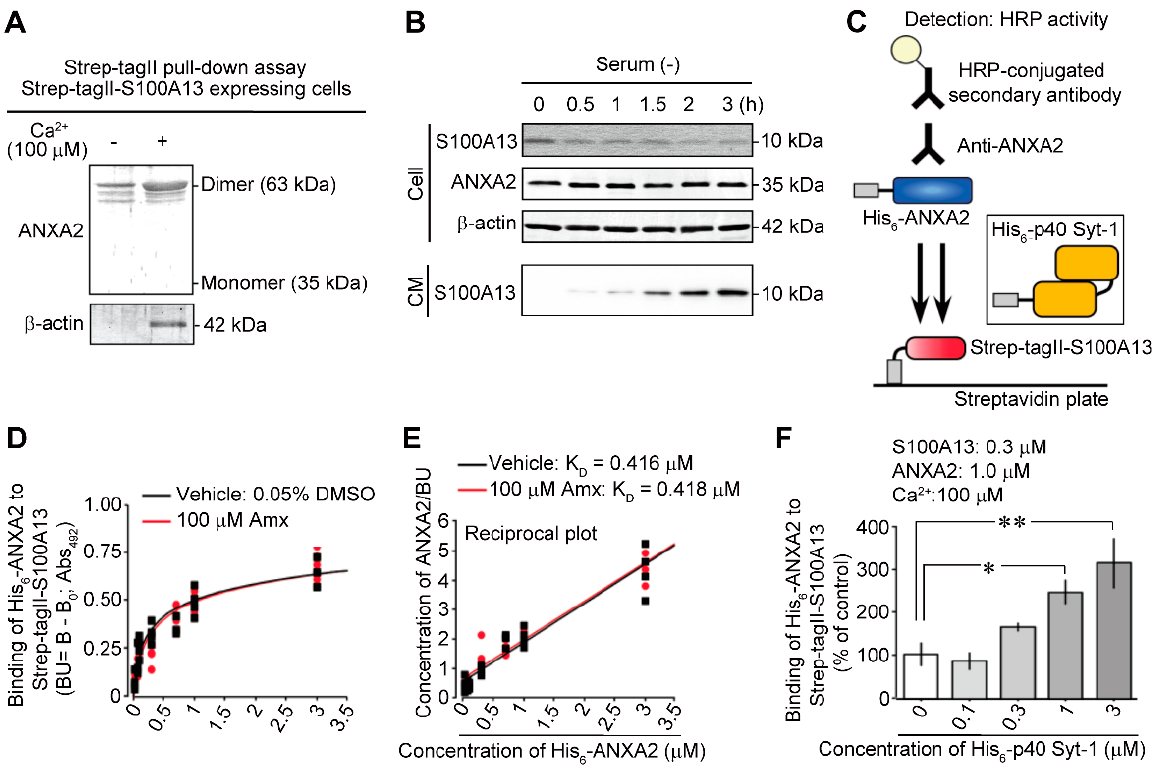
Figure 1. Evidence for Ca 2+ -dependent interaction between annexin A2 (ANXA2) and S100A13 under serum-free conditions. ( A ) Pull-down assay using Strep -tagII-S100A13. Strep -tagII-S100A13 and C6 glioma cell lysates were incubated in the absence (left lane) and presence (right lane) of 100 µ M Ca 2+ . Results represent the immunoblot using anti-ANXA2 IgG (upper lanes) and anti- β -actin antibody (lower lanes). The pull-down assay in Figure 1A showed that ANXA2 dimer interacts with Strep -tagII-S100A13 in C6 glioma cell lysates in a Ca 2+ -enhanced manner. In the previously published study [18], we have shown that p40 Syt-1 also interacts with Strep -tagII-S100A13 in C6 glioma cell lysates in a Ca 2+ -enhanced manner. As both pull-down assays using Strep -tagII-S100A13 have been done with the same C6 glioma cell lysates, it appears that S100A13 forms the same protein complex with both experiments p40 Syt-1 and ANXA2. The experiment was done using same C6 glioma cell lysates as previously reported to show the interaction between Strep- tagII-S100A13 and p40 Syt-1 [18]. ( B ) Serum- free-induced release of S100A13, but not ANXA2 from C6 glioma cells. Results represent the time course of protein levels of S100A13, ANXA2 and β -actin in cells (upper panels) and conditioned medium (CM) (lower panel) by immunoblot analysis. Extracellular S100A13 was recovered from CM using immunoprecipitation. ( C ) Schematic model of interaction between His 6 -ANXA2 and Strep -tagII-S100A13 bound to Streptavidin plate in an ELISA-based protein binding assay. Inset: enhancement of the interaction in the presence of His 6 -p40 synaptotagmin-1 (Syt-1). ( D , E ) No effect of amlexanox (Amx) on the His 6 -ANXA2 binding to Strep -tagII-S100A13 in terms of analyses of His 6 -ANXA2 concentration-dependency ( D ) and its reciprocal plot ( E ). ( F ) His 6 -p40 Syt-1 concentration-dependent enhancement of His 6 -ANXA2 binding to Strep -tagII-S100A13 in the presence of Ca 2+ . Data are presented as the mean ± standard error of the mean (S.E.M.) from a Tukey–Kramer multiple comparison test. * p < 0.05 and ** p < 0.01. n = 4 experiments per